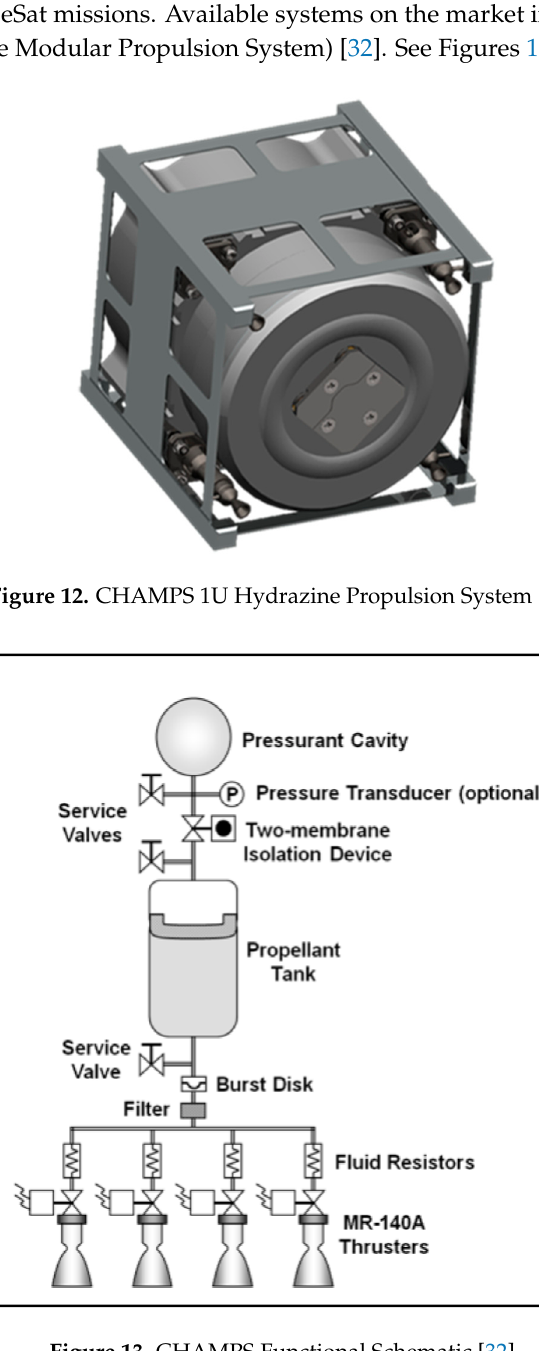
Table 6. CHAMPS Performance Specification.